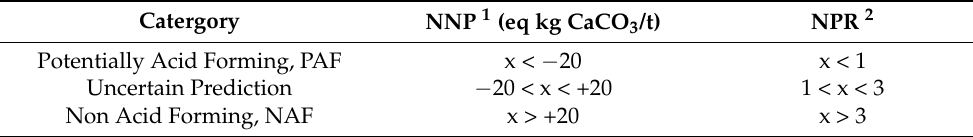
Table 2. For samples where the NNP and NPR do not lie within the same field (e.g., NPR < 1 but NNP > − 20) the worst of the two cases is taken (i.e., in the example the material would be classed as potentially acid forming). Table 2. Interpretation of ABA data [29]. Catergory NNP 1 (eq kg CaCO 3 /t) NPR 2 Potentially Acid Forming, PAF x < − 20 x < 1 Uncertain Prediction Non Acid Forming, NAF